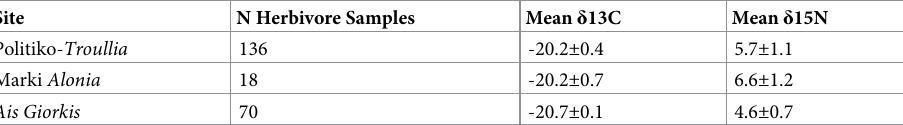
Table 2. Mean and standard deviation of herbivore taxa at three Cypriot sites.